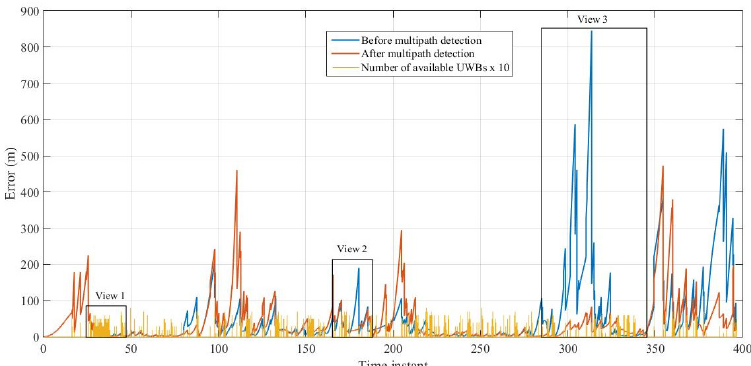
Figure 26. Localization error for UAV 103 in the developed distributed cooperative swarm. The number of UWB nodes available to UAV 103 are also shown.